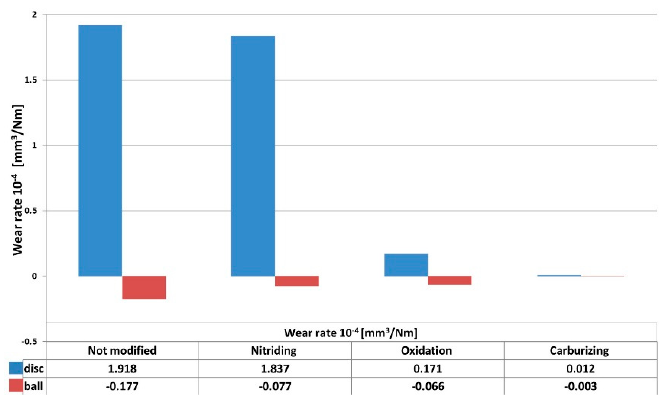
Figure 6. Wear rates of Ti6Al4V and ZrO 2 counterbody: not modified, after nitriding, after oxidation, after carburizing.